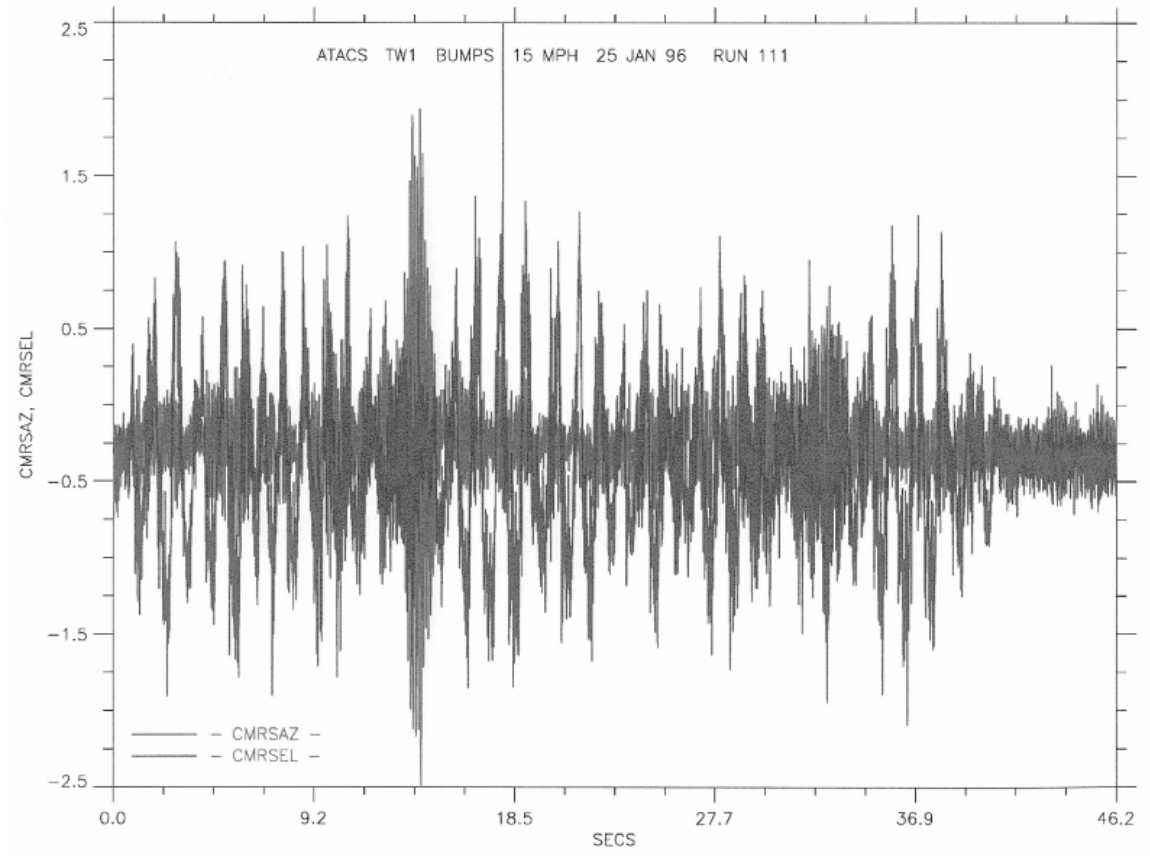
Fig. 4. CMRS azimuth and elevation time history over RRC-9 bump course at 15 mph.